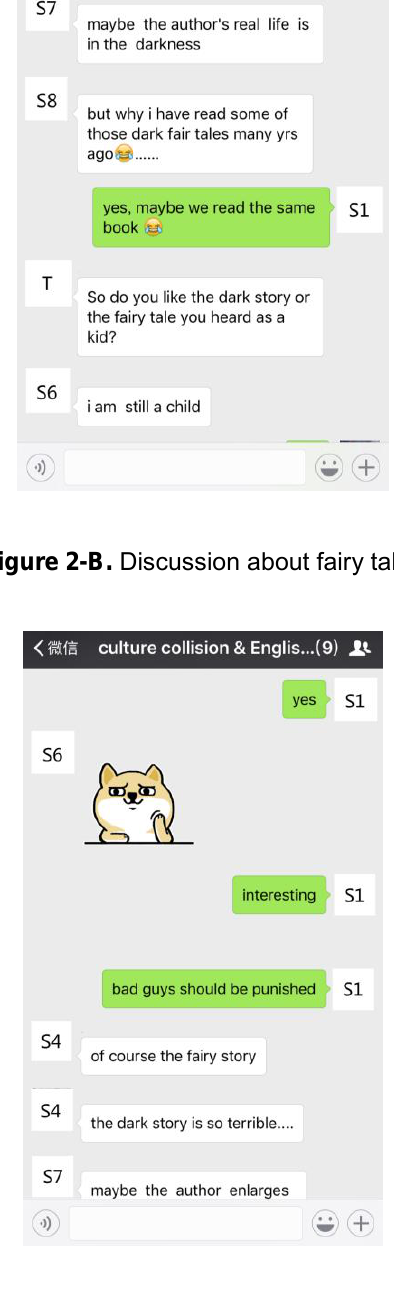
Figure 2-C. Discussion about fairy tales Different from most previous mobile learning studies, which involved student collaboration, the case study presented here